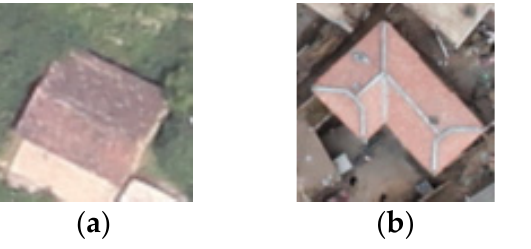
The bold font indicates the best accuracy of each indicator.